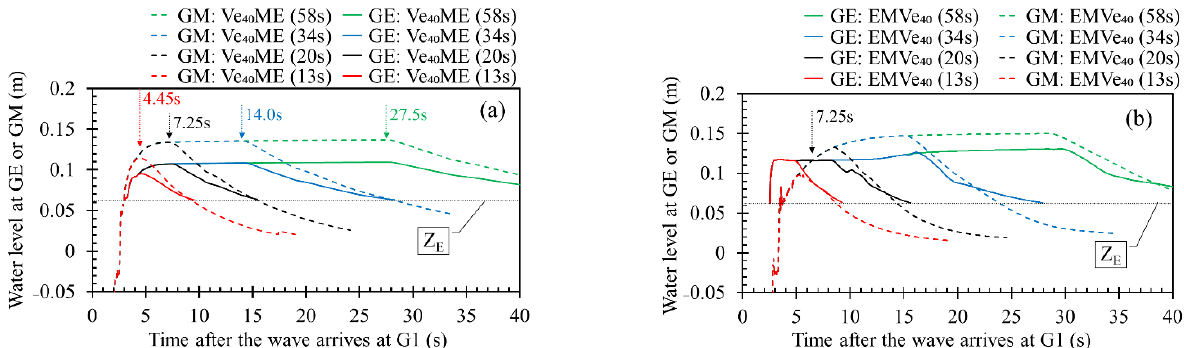
Figure 8. Time series of water levels at G3 for H D = 1.42 for the wave period: ( a ) 13 s, ( b ) 20 s, ( c ) 34 s, and ( d ) 58 s.